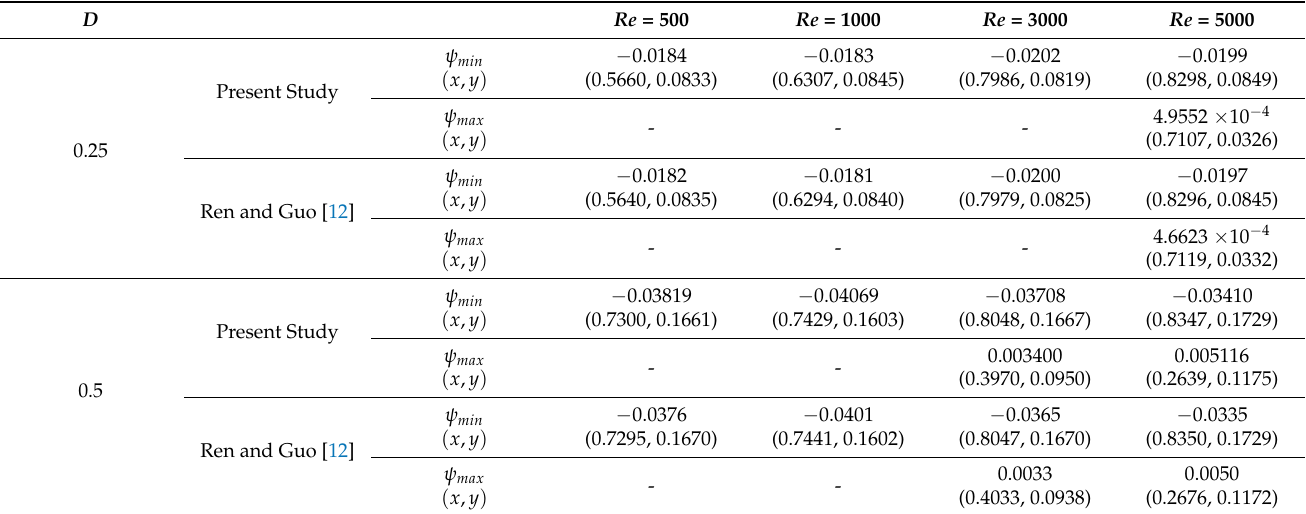
Table 2. Comparison of flow properties for D = 0.25 and 0.5 aspect ratio semi-ellipses.